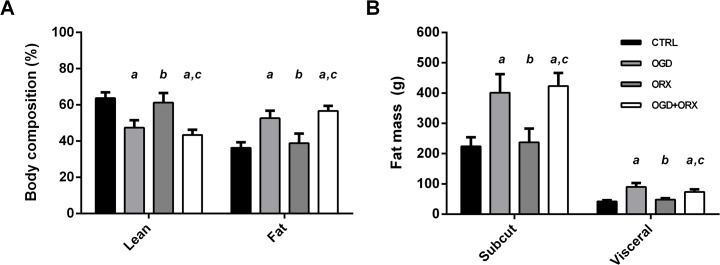
Body composition analysis.(A) Body composition expressed as a percentage of total body weight. (B) Subcutaneous and visceral fat distribution. CTRL–control, OGD–obesogenic diet-fed, ORX–orchiectomised. Letters denote significant differences between respective groups, p<0.05 (a vs. CTRL, b vs. OGD, c vs. ORX).